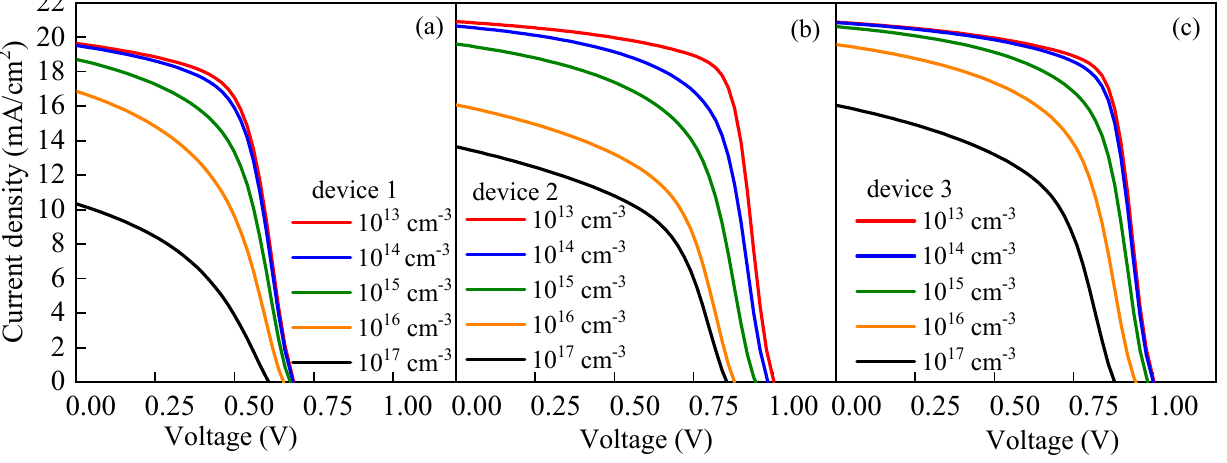
Figure 10. Effect of Nt on the J–V characteristic curve: ( a ) effect of N t on J-V characteristic curve of device 1, ( b ) effect of N t on J-V characteristic curve of device 2, and ( c ) effect of N t on J-V characteristic curve of device